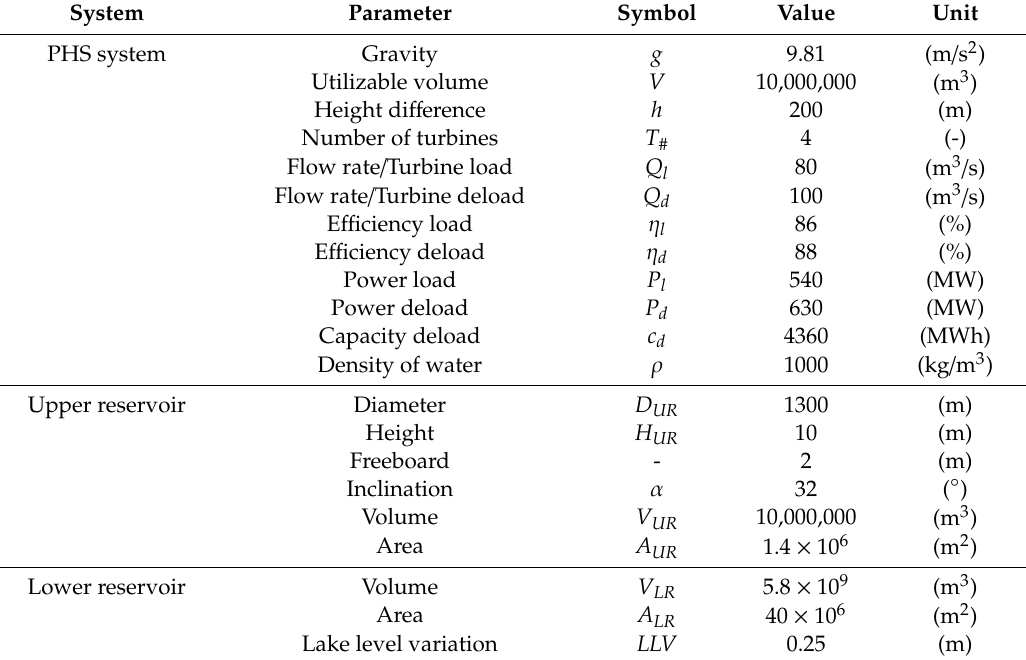
Table 3. System-related parameter and technical specifications exemplary for Scenario